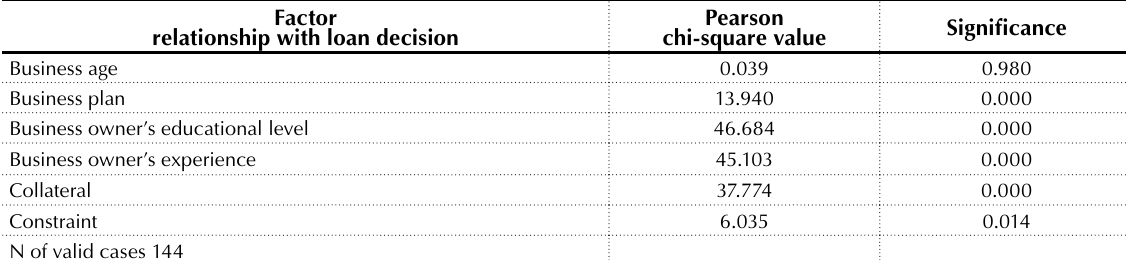
Table 7. Chi-square